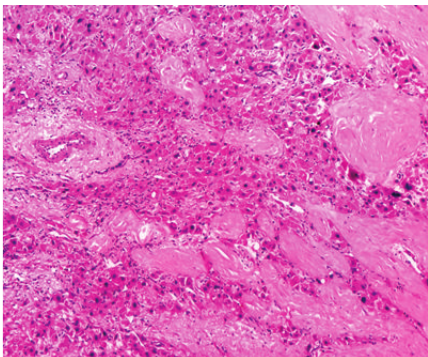
Figure 3: Fibrolamellar carcinoma showing tumor cells with abundant eosinophilic cytoplasm separated by lamellar bands of hyalinised collagen, hematoxylin-eosin 100x.